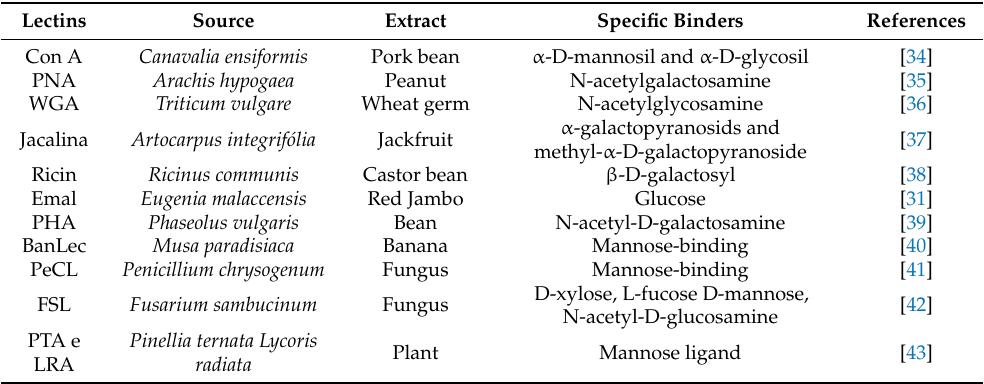
Table 1. Lectins and their specific